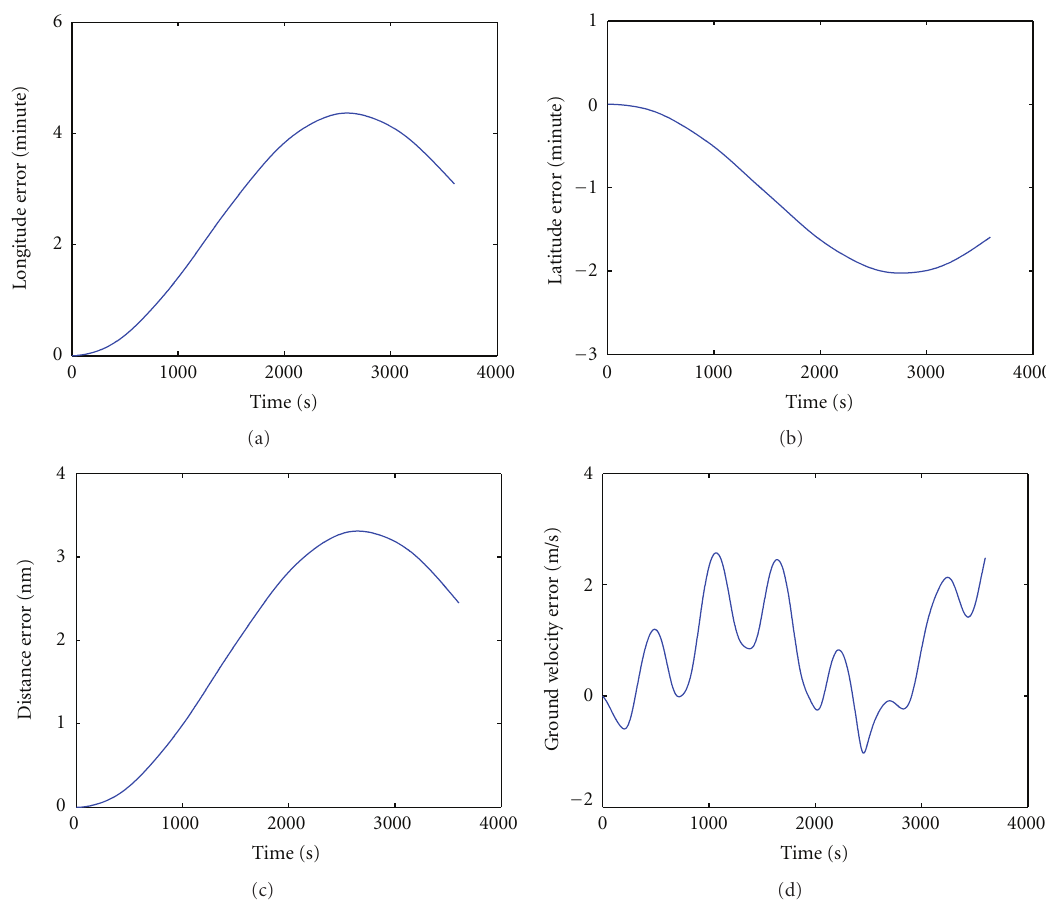
Figure 20: Position and velocity error of s-shape